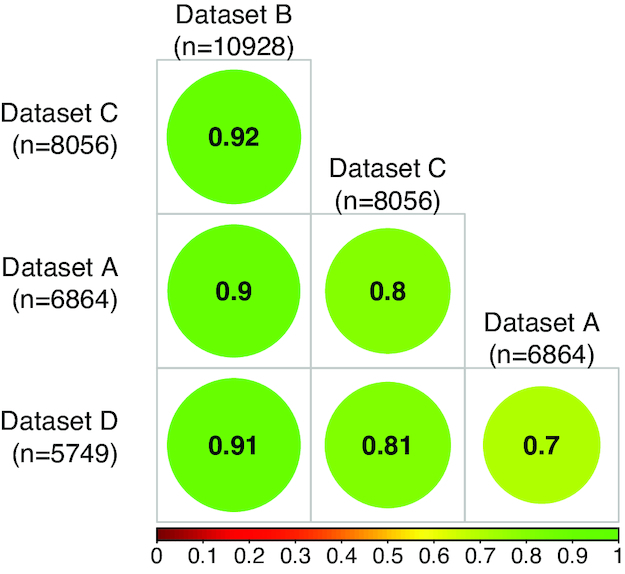
Proportions of overlapping CNVRs amongst datasets. Pairwise comparisons of the proportions of CNVRs in each dataset (rows; ordered by dataset size) that overlap by ≥1 base pair with CNVRs of other larger datasets (columns) are presented.